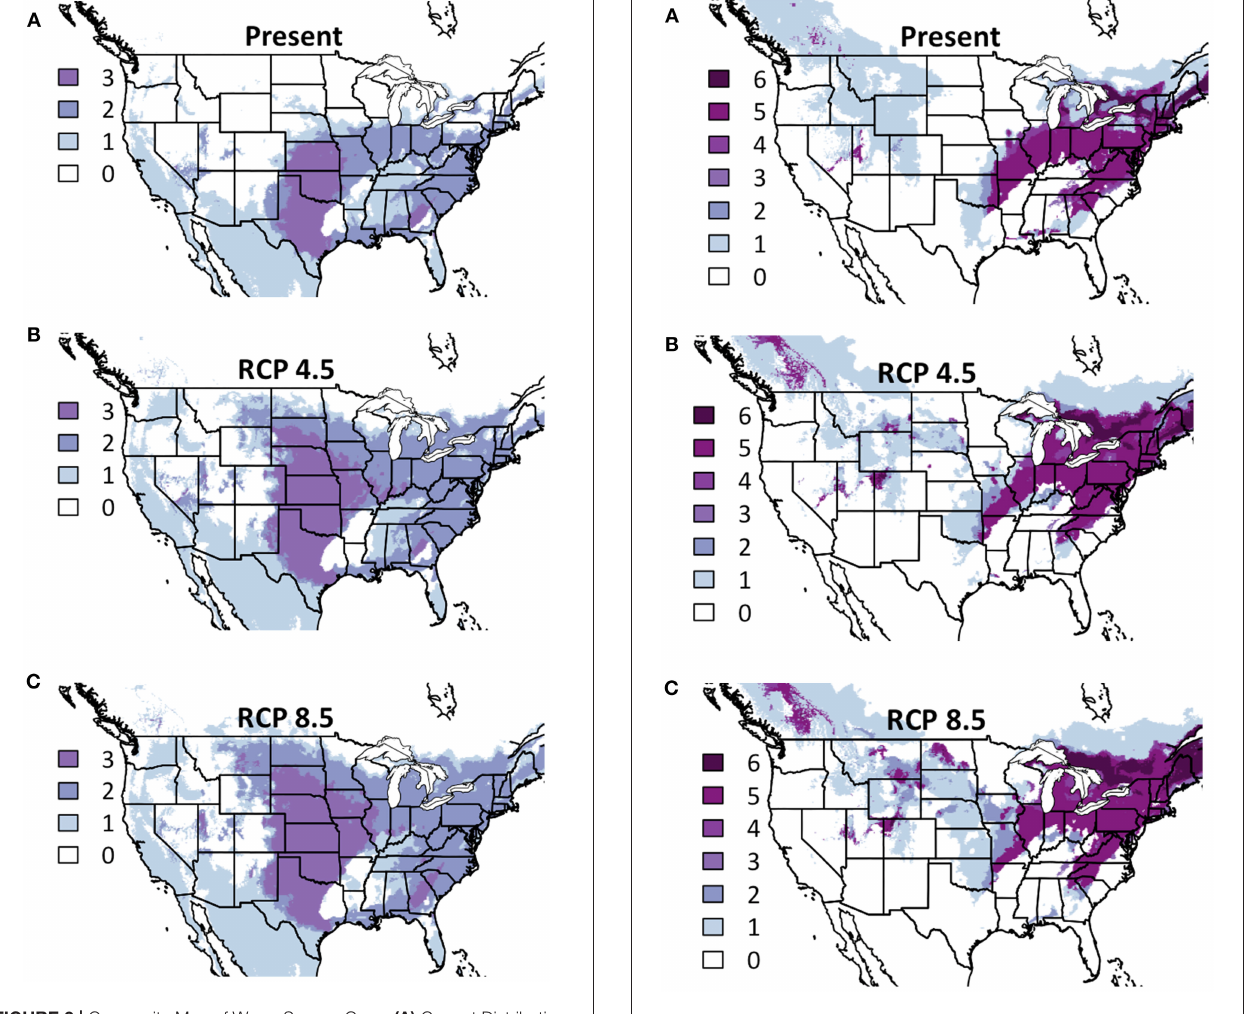
FIGURE 3 | Composite Map of Forb (A) Current Distribution and Response to (B) RCP 4.5, and (C) RCP 8.5. Colors indicate the number of species where suitability is predicted to ≥ 50%. Darker colors indicate areas where bioclimatic suitability is above the threshold for more species. Included species are Asclepias incarnata , A. syriaca , A. tuberosa , Drymocallis arguta , Lobelia siphilitica , and Monarda fistulosa . Time period is identified in the top of each